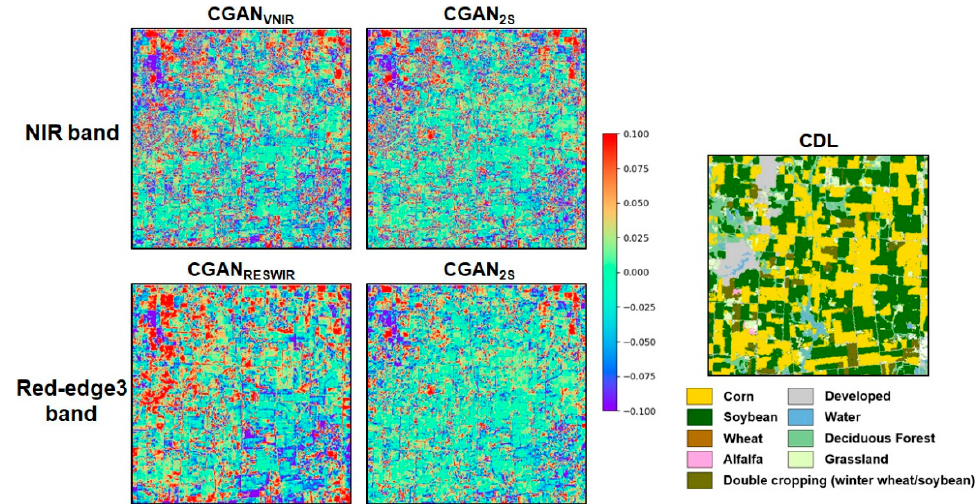
Figure 12. Error distributions over the study area of NIR and red-edge3 bands for different CGAN models with the CDL.